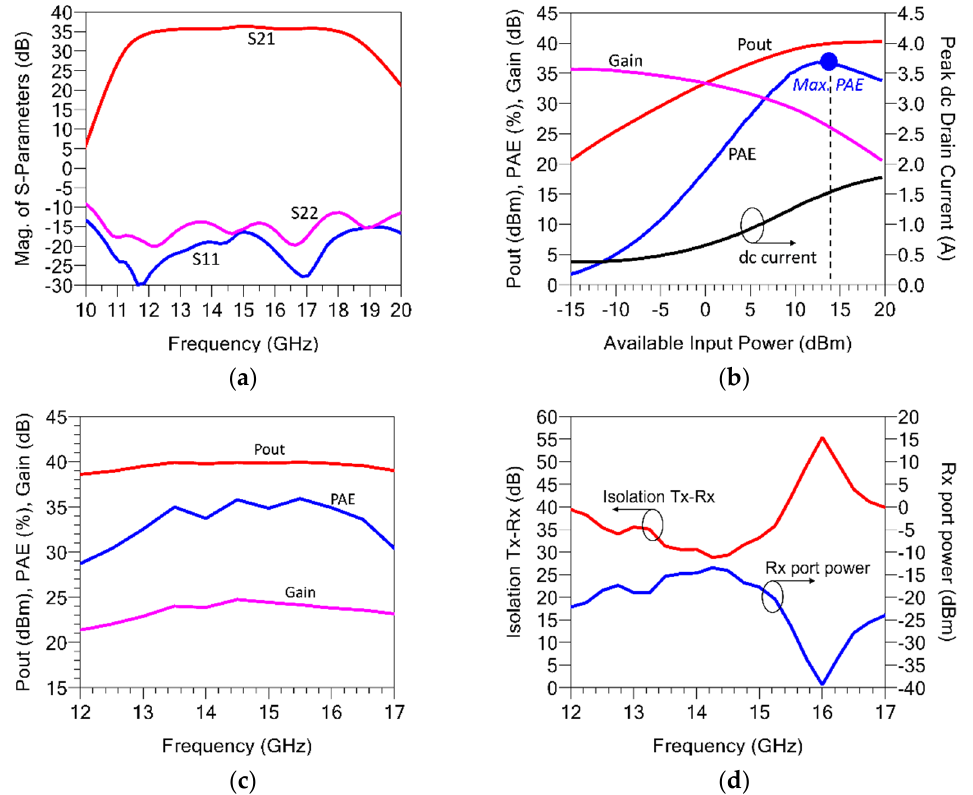
Figure 4. Ku-band SCFE-measured performance in Tx mode. ( a ) Measured S-parameters; ( b ) output power, PAE and gain as a function of the available input power; ( c ) output power, PAE and gain and ( d ) Tx–Rx port isolation and Rx port leakage output power at fixed available power Pavs = 14 dBm as a function of frequency. Bias and control voltages are set according to Table 1.